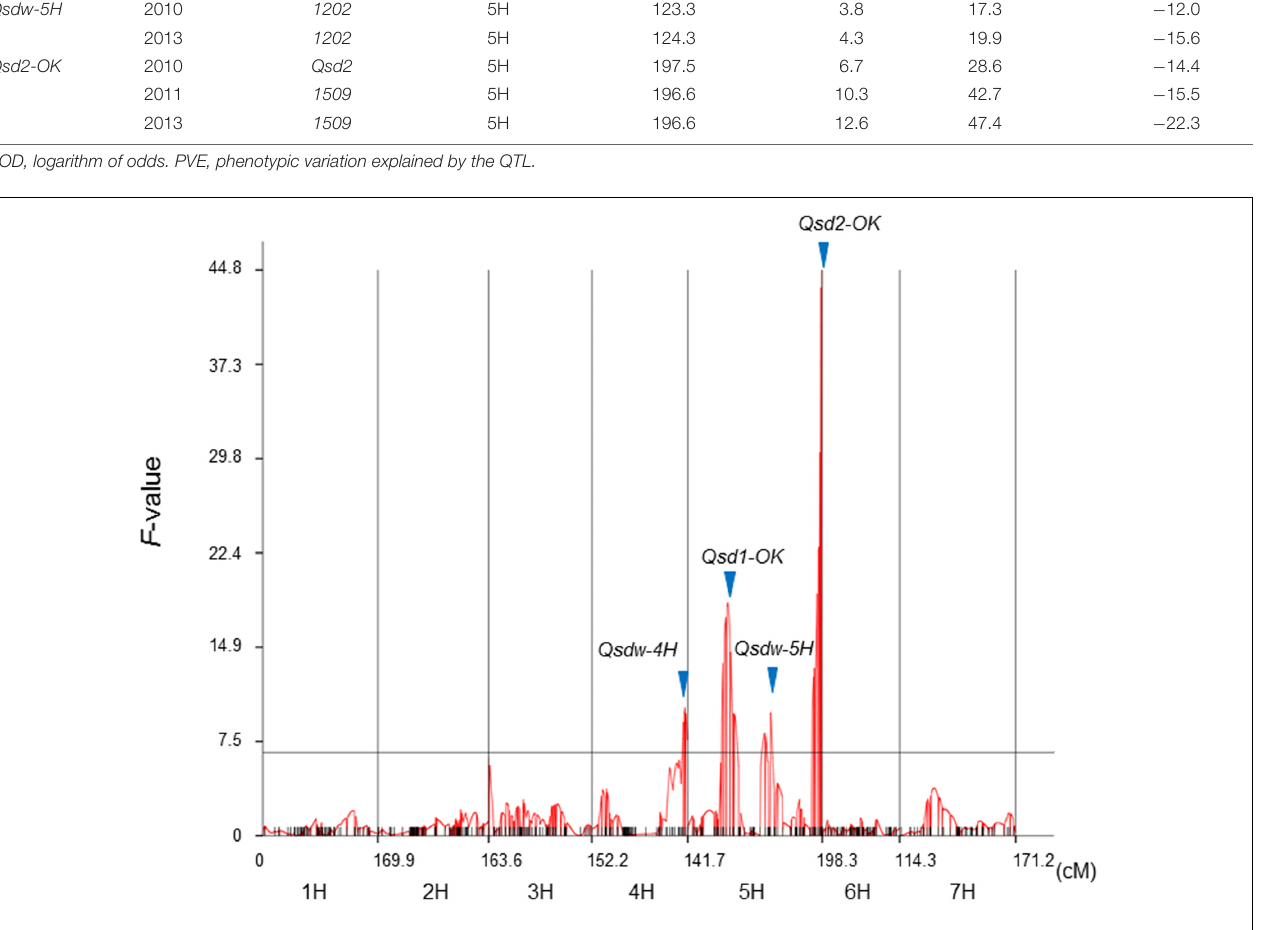
FIGURE 2 | Quantitative trait loci (QTL)-likelihood curves generated by QTLNetwork. Germination data of the RILs with three replications in 3 years, 2010, 2011, and 2013, were used for data processing. Blue arrows indicate the detected QTL locations. The horizontal black line indicates the QTL threshold equivalent to a critical F -value of 6.58 ( p < 0.05). cM: centiMorgan.